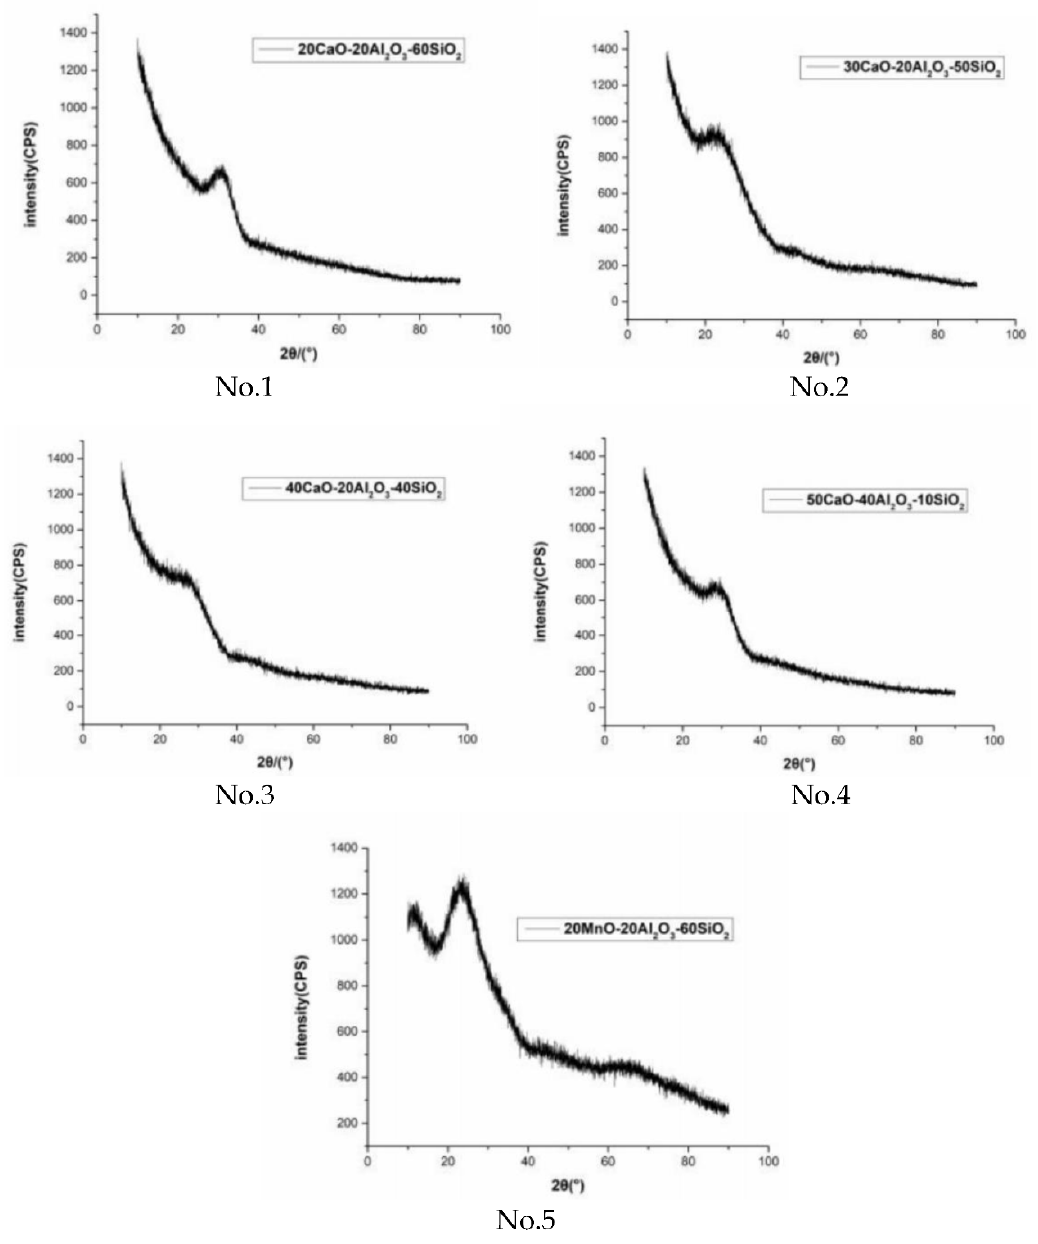
Figure 1. The XRD pattern for samples showing the glassy state of samples.